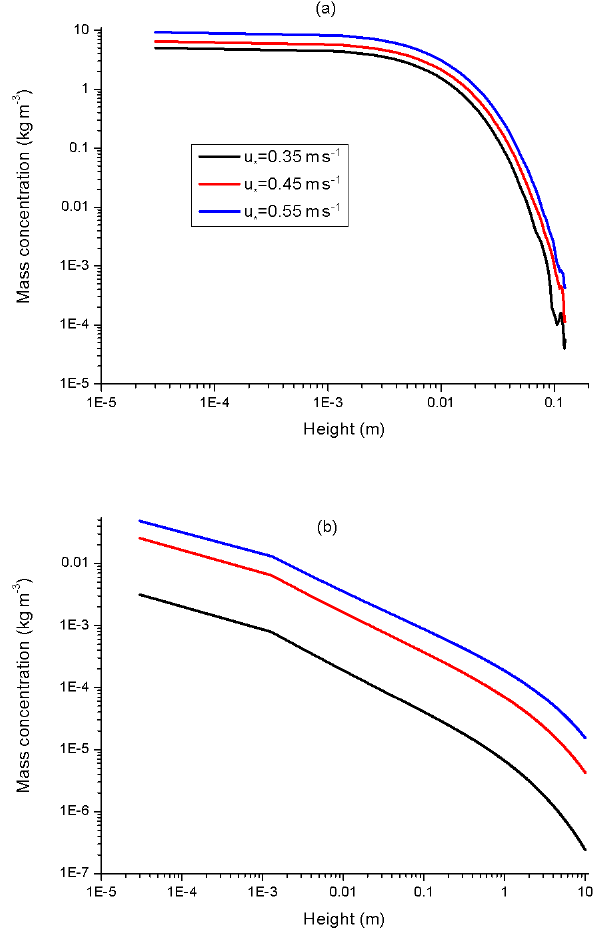
Figure 10. Vertical profiles of mass concentration for saltation and suspension: (a) saltating particles, (b) suspended